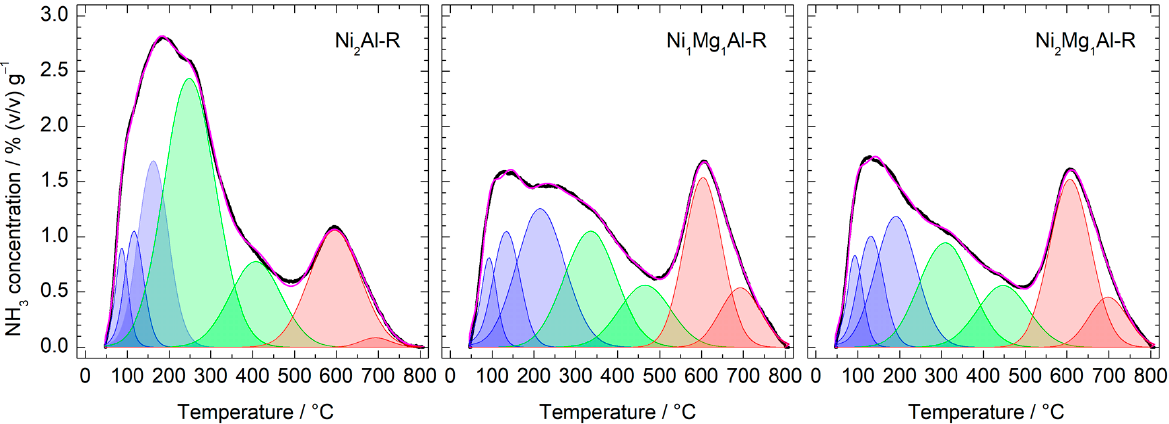
Figure 6. Acidic groups on the reduced catalysts by NH 3 -TPD. Black line: recorded signal. Red line: deconvoluted signal. Blue peaks = weak ( α ); green peaks = intermediate ( β ); red peaks = strong sites ( γ ).